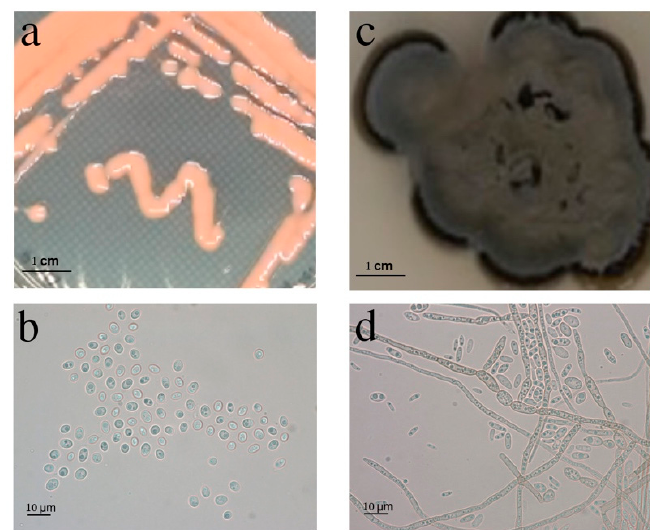
Figure 1. Macroscopic and microscopic morphology of the isolates BMH1012 and BMH1013. Macroscopic view of the strain BMH1012 ( a ) and BMH1013 ( c ) growing on a PDA Petri dish. Microscopic view of contrast phase of strain BMH1012 ( b ) and BMH1013 ( d ). Bar size: 10 μ m.